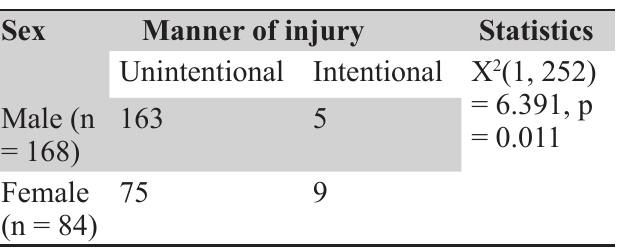
Table 2. Relationship between gender and manner of injuries